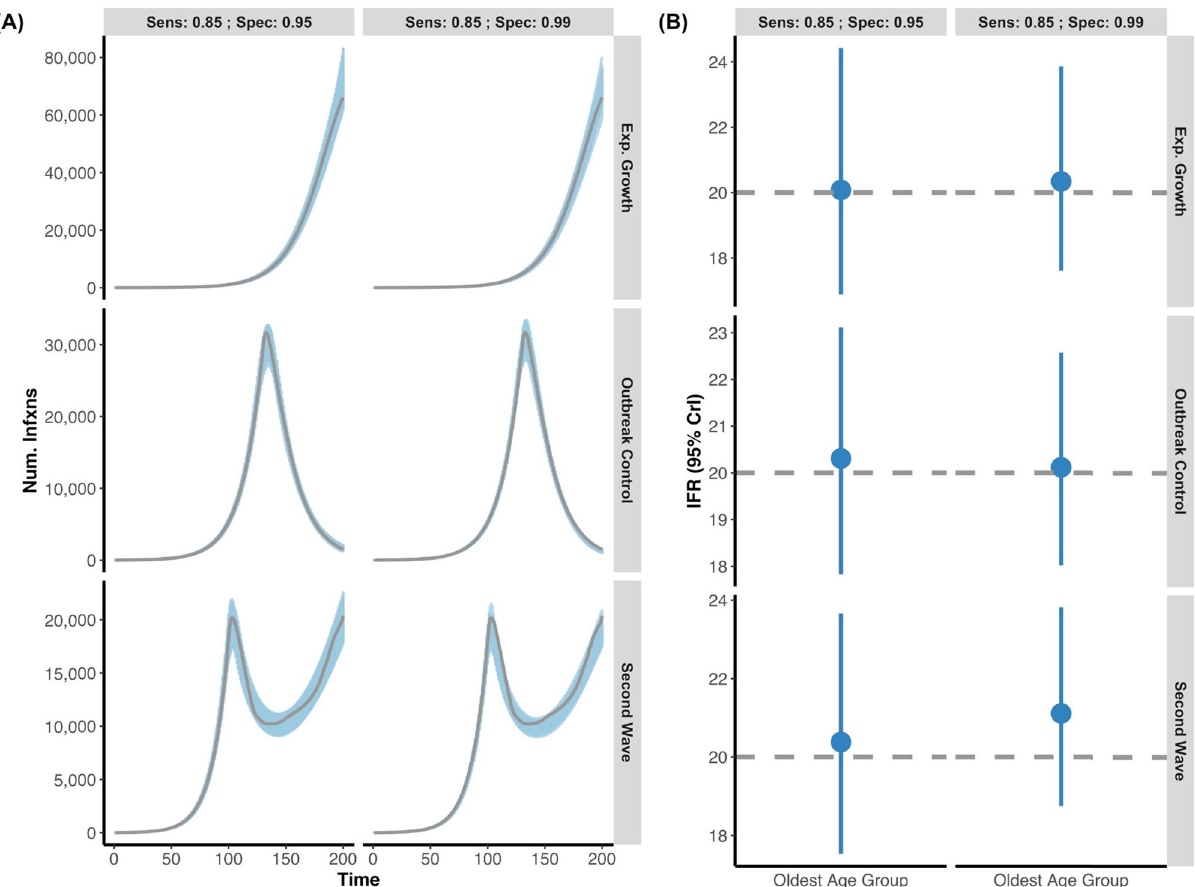
Fig. 3 Posterior daily infections and IFR estimates from simulated data with seroreversion. A Three simulated epidemics were generated (exponential growth, outbreak control, and second wave) as in Fig. 2, but now with the additional feature that individuals who seroconverted would eventually serorevert. Grey lines indicate the simulated true infection curve under two different serologic tests (Sensitivity: 85%; Speci fi city 95% vs. Sensitivity: 85%; Speci fi city 99%). The blue shading represents 100 posterior draws (based on the posterior probability) of the modelled infection curve (using an exponentiated natural cubic spline), where draws were selected based on their posterior probability. B The inferred median and 95% credible intervals (blue) versus the simulated true IFR (grey, dashed line) in the oldest age group for each of the outbreak scenarios with respect to the two different serologic test characteristics. As above, the model accurately captures both the simulated infection curve and the simulated IFR while accounting for seroreversion. For all epidemic scenarios considered, we assume that there are two seroprevalence surveys that range over days 120 – 130 and 170 – 180 and that 0.1% of the population was